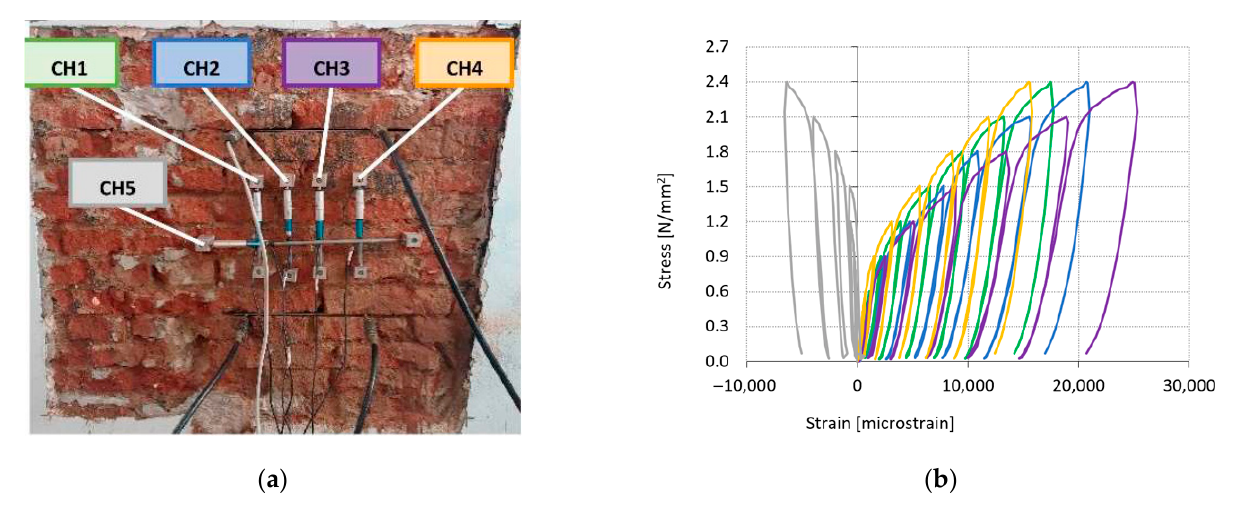
Figure 8. ( a ) 3D Sensors’ layout; ( b ) Stress-strain relationship measured at different sensors.